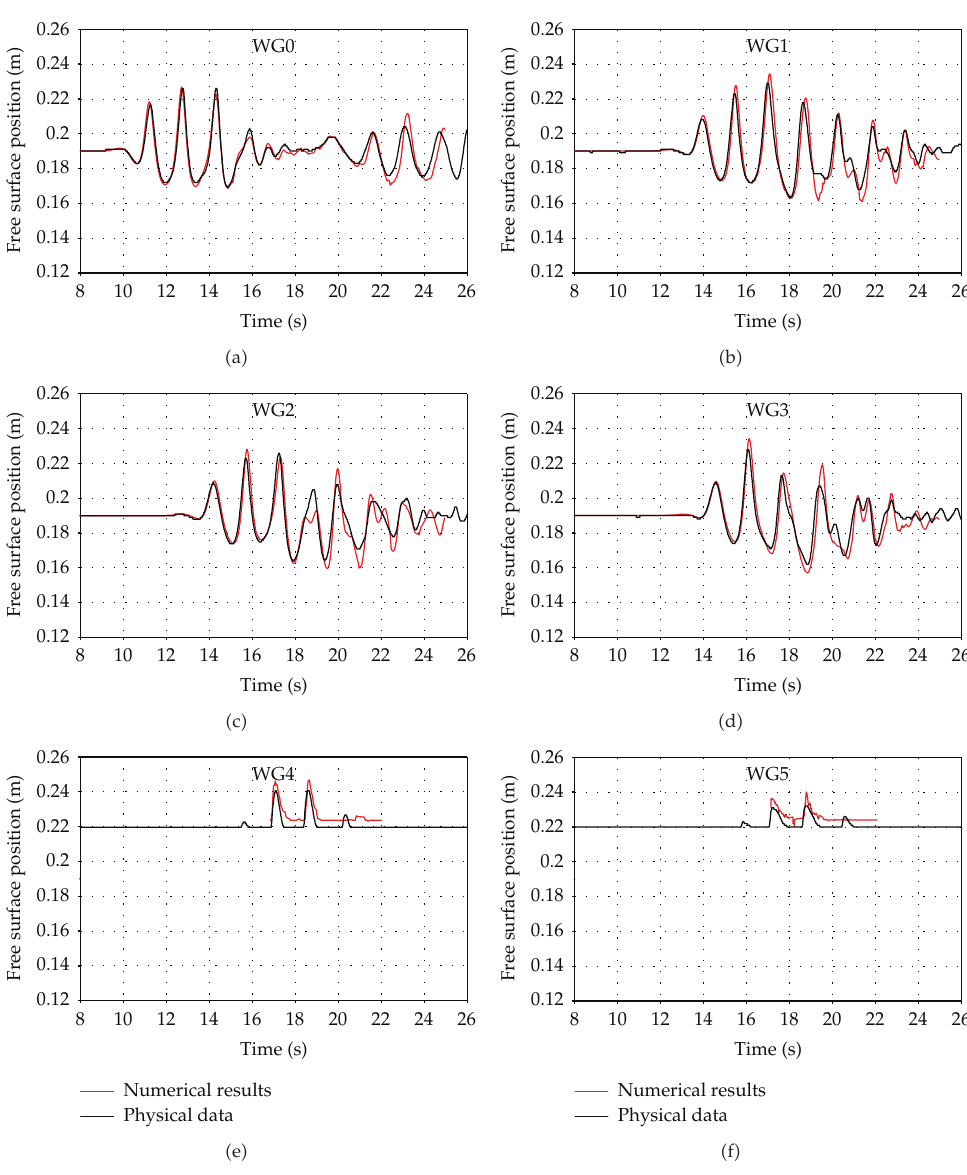
Figure 4: Numerical and physical free surface comparison at six di ff erent locations, all of them corresponding to wave case 1 defined by H (cid:9) 0 . 06m and T (cid:9) 1 . 55s.